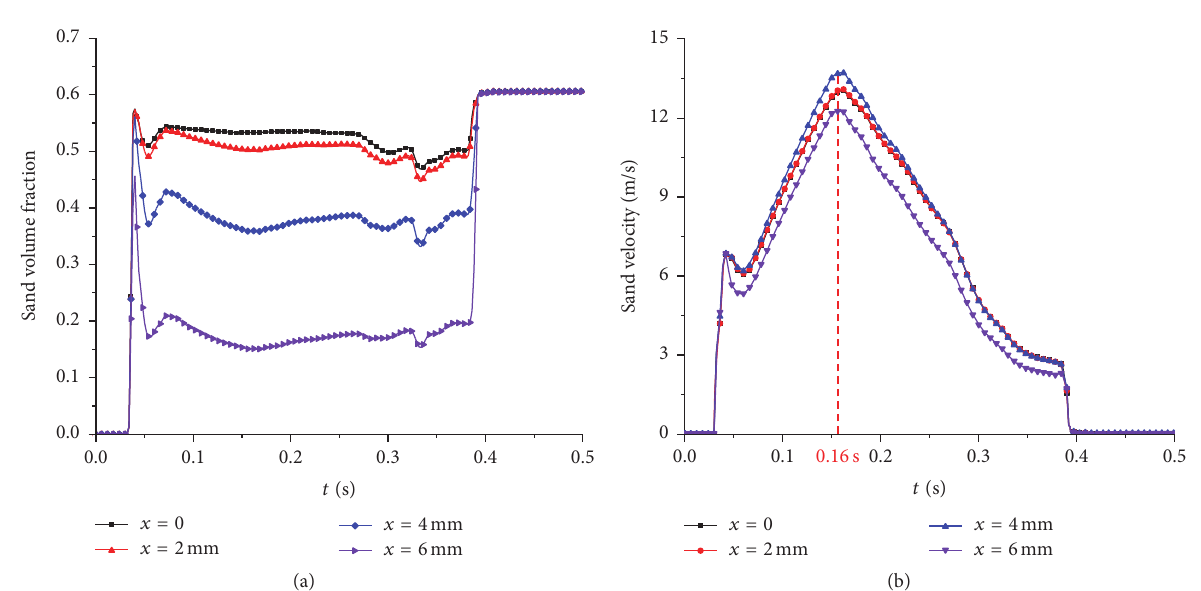
Figure 7: The variations of (a) sand volume fraction and (b) sand velocity at the nozzle over time ( 𝑥 is the distance to the